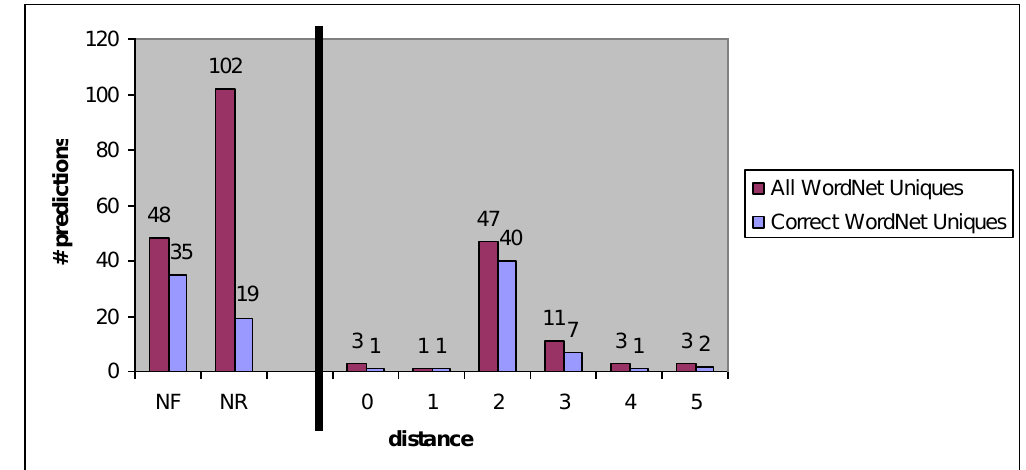
Figure 2: Distance at which WordNet-unique parent-child predictions were retrieved in UMLS. NF = Not Found, NR = Not